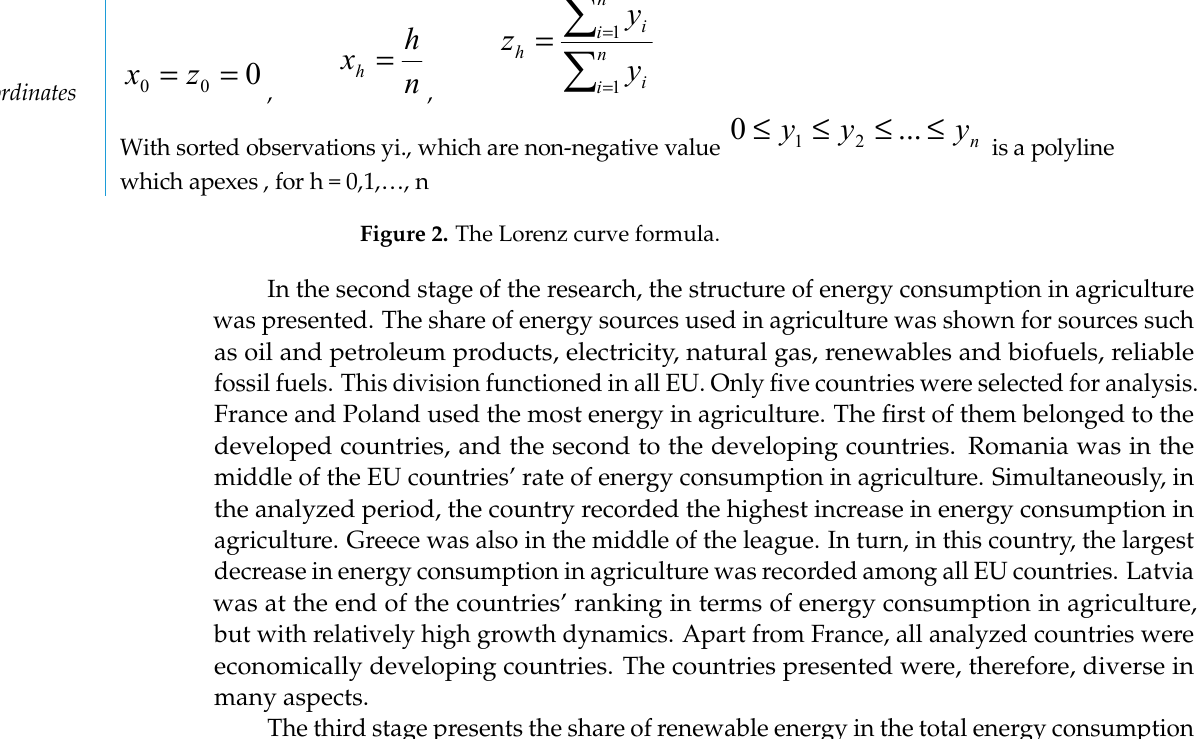
Figure 2 . The Lorenz curve formula .